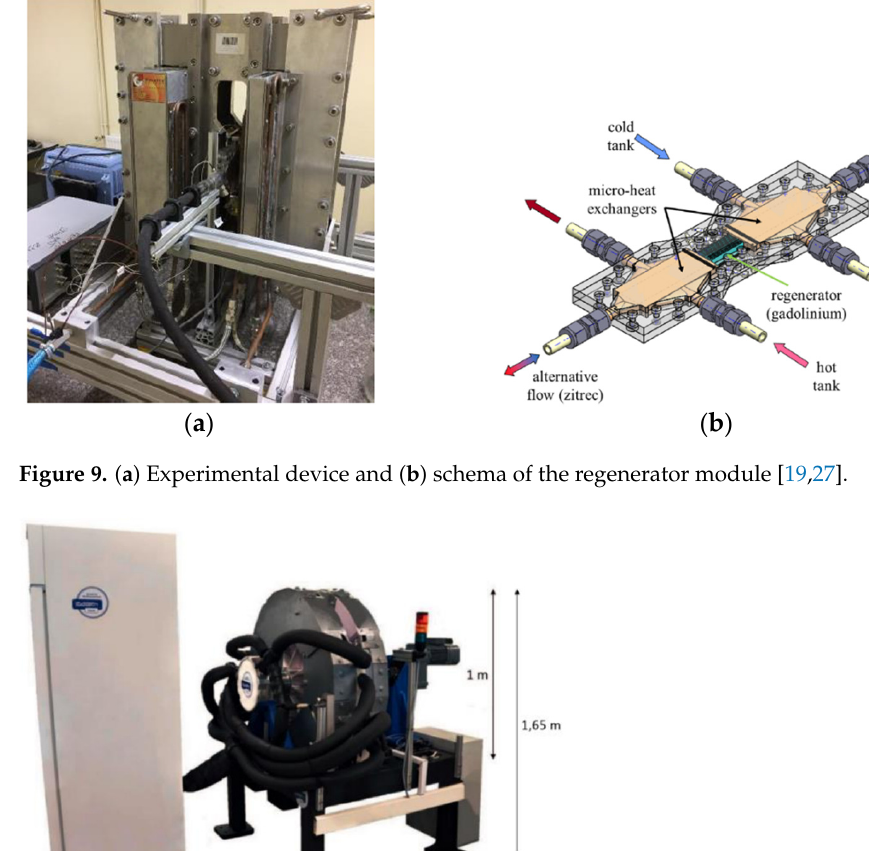
Figure 8. Device ( a ) and operating schematic ( b ) of Jacob et al. [49]. Mira (2014) [27] and Plait (2018) [19] developed an experimental device (Figure 9). The magnetic field source is an electromagnet composed of four coils generating a mag- netic flux density of 1 T in an air-gap of 2.1 cm. The goal was to characterize the thermo- fluidic behavior and to maximize the performances of the device. This last reached a tem- perature range of 7 K at the outputs of the regenerator.